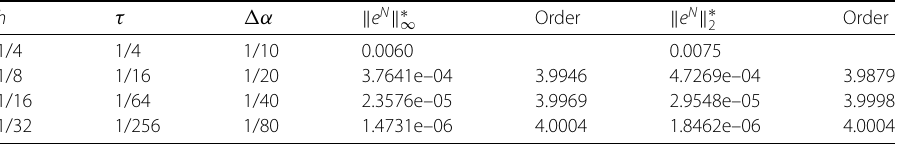
Table 3 The discrete L 2 errors, maximum errors, and convergence rates for scheme (16) for Example 1 with v 1 = 0.1 and v 2 = 0.9